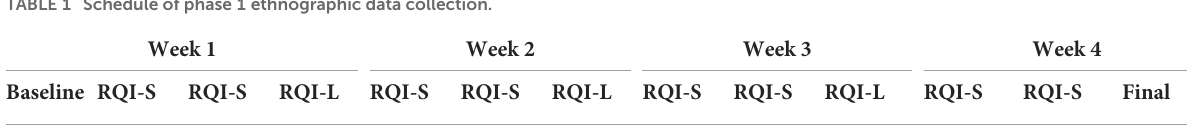
TABLE 1 Schedule of phase 1 ethnographic data